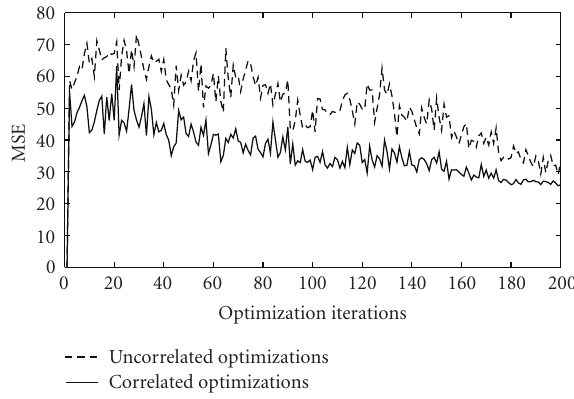
Figure 14: Number of generations necessary to achieve a precision of 10 − 6 with correlated and uncorrelated genetic optimizations of LSC, Pop size =